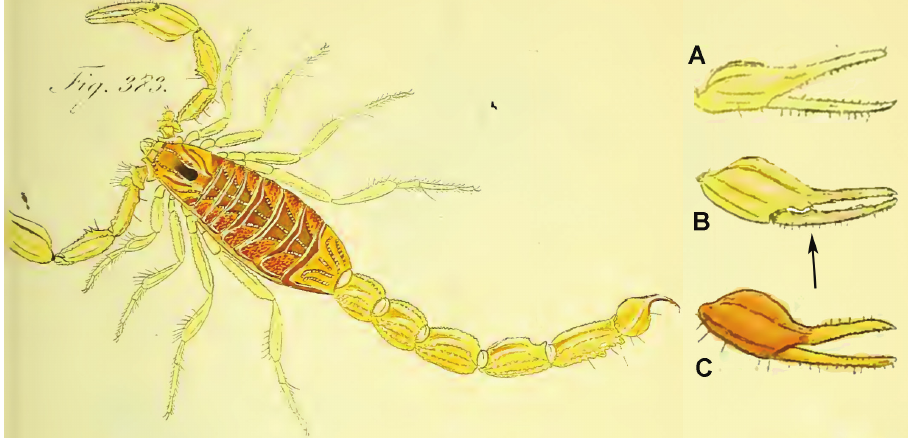
Figure 13. Reproduction of C. L. Koch’s 1839 B. halius figure 382 (plate CLXIII). Right pedipalp che- lae detail from three Buthus species published in the same work: A B. paris (as Androctonus clytoneus ), fig. 384 (same plate) B B. halius with an arrow pinpointing the basal lobe C B. paris , fig. 352 (pl. CLI). All images were taken as provided by the pdf copy available in the BHL, which was made available by the Ernst Mayr Library of the Museum of Comparative Zoology, Harvard